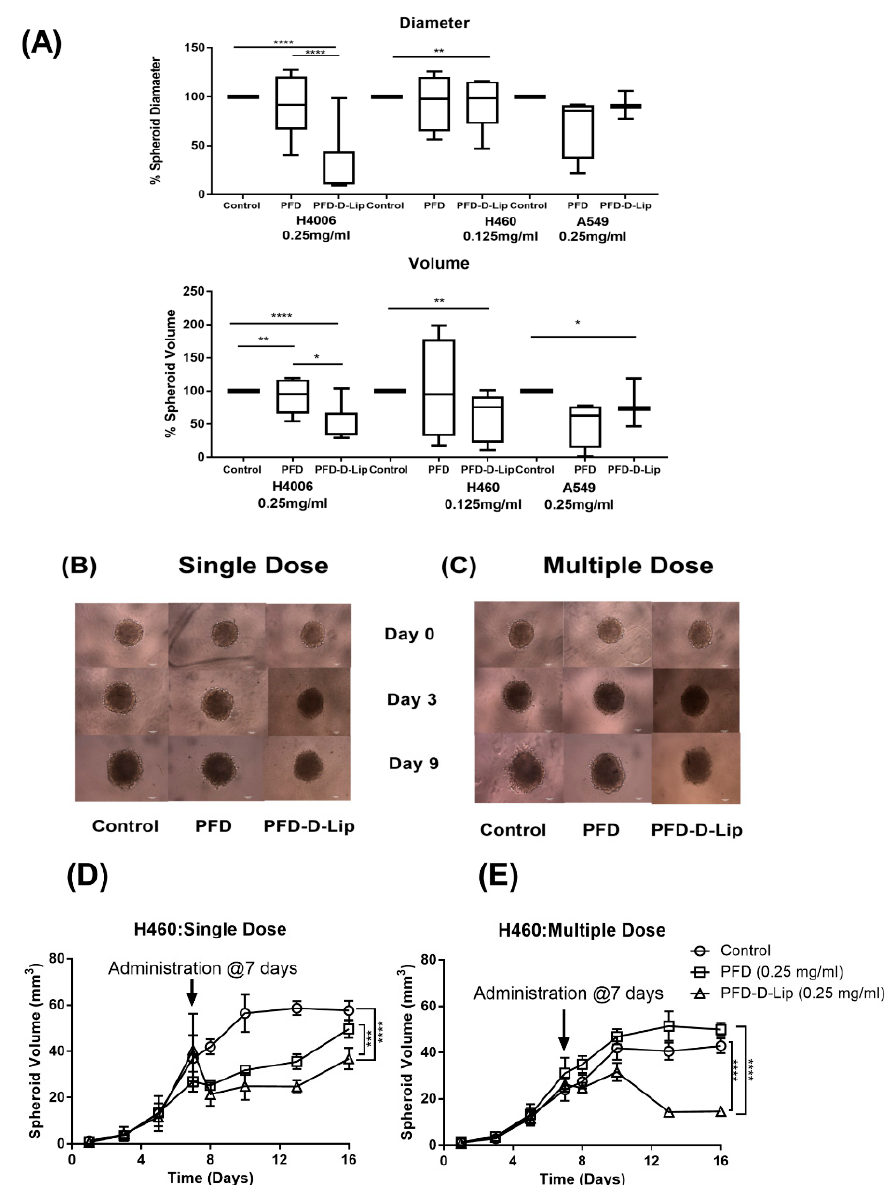
Figure 10. ( A ) Prophylactic model for 3D spheroid study in NSCLC cell lines. A549, H460, and H4006 cells were treated with control, PFD, and PFD–D-Lip (A549: 0.25 mg/mL; H460: 0.125 mg/mL, and H4006: 0.25mg/mL). Spheroid diameter and volume on 15th day of treatment are represented as % reduction from control groups. ( B,C ) Effect of treatment on growth of tumor in A549 3D spheroids after either single ( B ) or multiple dose ( C ). Images represent the spheroids before treatment (day 0) and post treatment (days 3, 9). ( D , E ) Spheroids of H460 were treated with PFD–D-Lip showed significantly reduced spheroid size in comparison to control and PFD after 9 days of treatment. Data represent mean ± SD ( n = 6). Scale bar for the images represents 400 μ M. * p ( α < 0.05), ** p ( α < 0.01), **** p ( α < 0.0001).